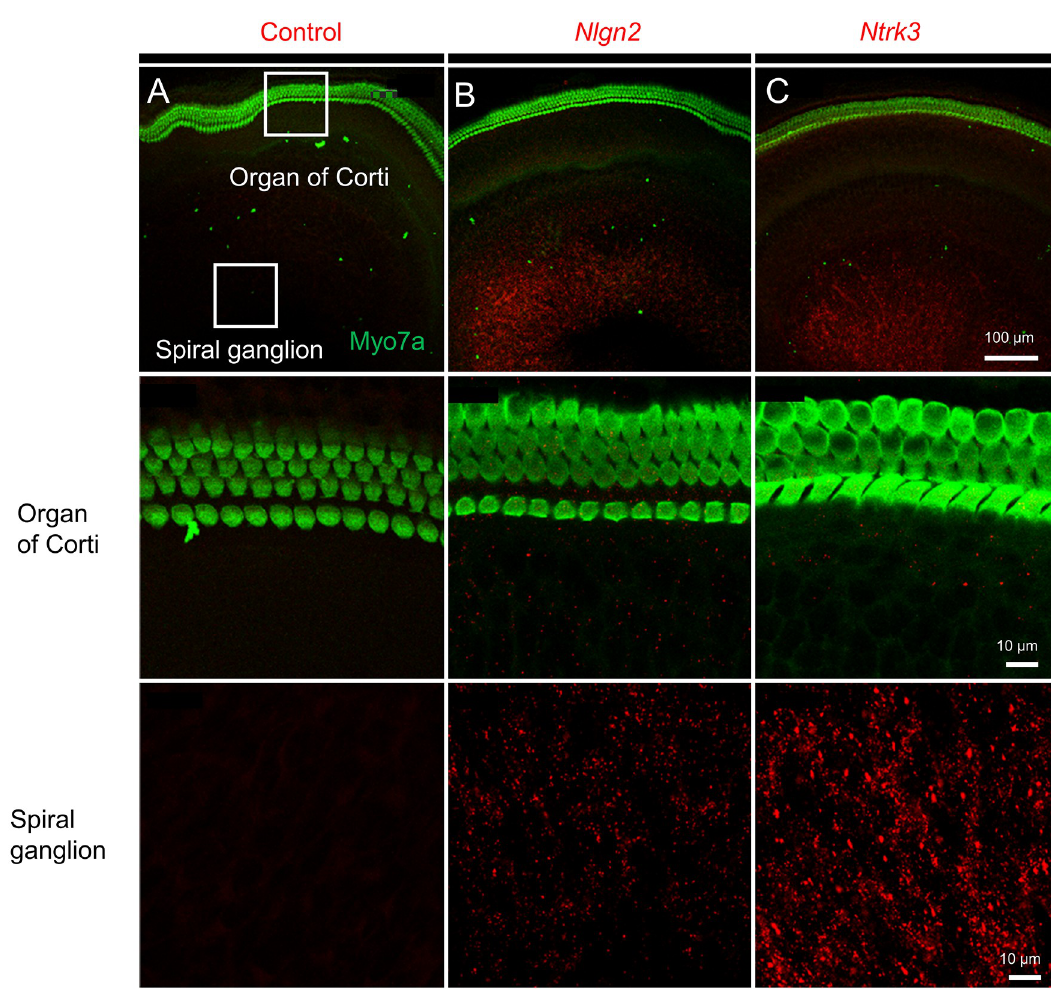
Fig 8. In situ hybridization assay utilizing RNAscope detects RNA for Nlgn2 and Ntrk3 within P4 cochlear whole mounts. (A) Cochlear whole mounts treated with negative control sense probe for Nlgn2 show no signal. Hair cells were immunostained with anti-Myo7a antibody (green). (B) Nlgn2 is expressed in the region of spiral ganglion neurons (red), but not hair cells (green). A magnified view of the SGN region (last row) identifies individual RNA molecules of Nlgn2 as red dots. (C) Ntrk3 is expressed in the SGN region (red), but not hair cells (H, green). A magnified view of the SGN region (last row) reveals abundant Ntrk3 expression. Representative pictures based on 4 different animals.